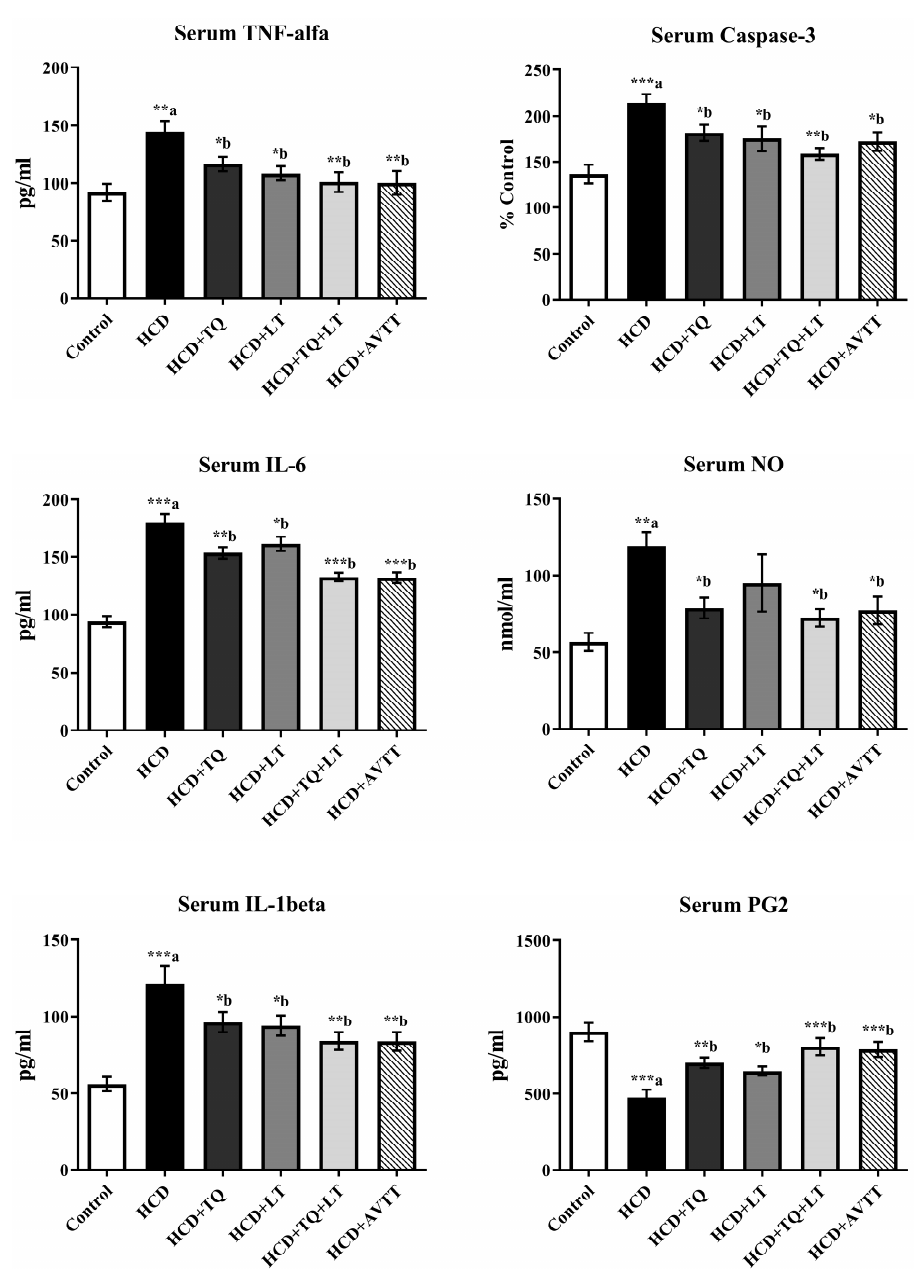
Figure 5. Effect of thymoquinone (TQ), losartan (LT) and their combination on high cholesterol diet (HCD)-induced changes in serum levels of proinflammatory interleukins including tumor necrosis factor-alpha (TNF-alpha), interleukin-6 (IL-6) and interleukin-1beta (IL-1beta) and levels of caspase-3, nitric oxide (NO) and prostaglandin E-2 (PG-2). Data were expressed as Mean ± SE (n = 6) and analyzed using one-way ANOVA followed by Student–Newman–Keuls as post hoc test. a Control vs. HCD group; b HCD vs. QT or LT or QT + LT. p values considered significant when * p < 0.05, ** p < 0.01 and *** p <